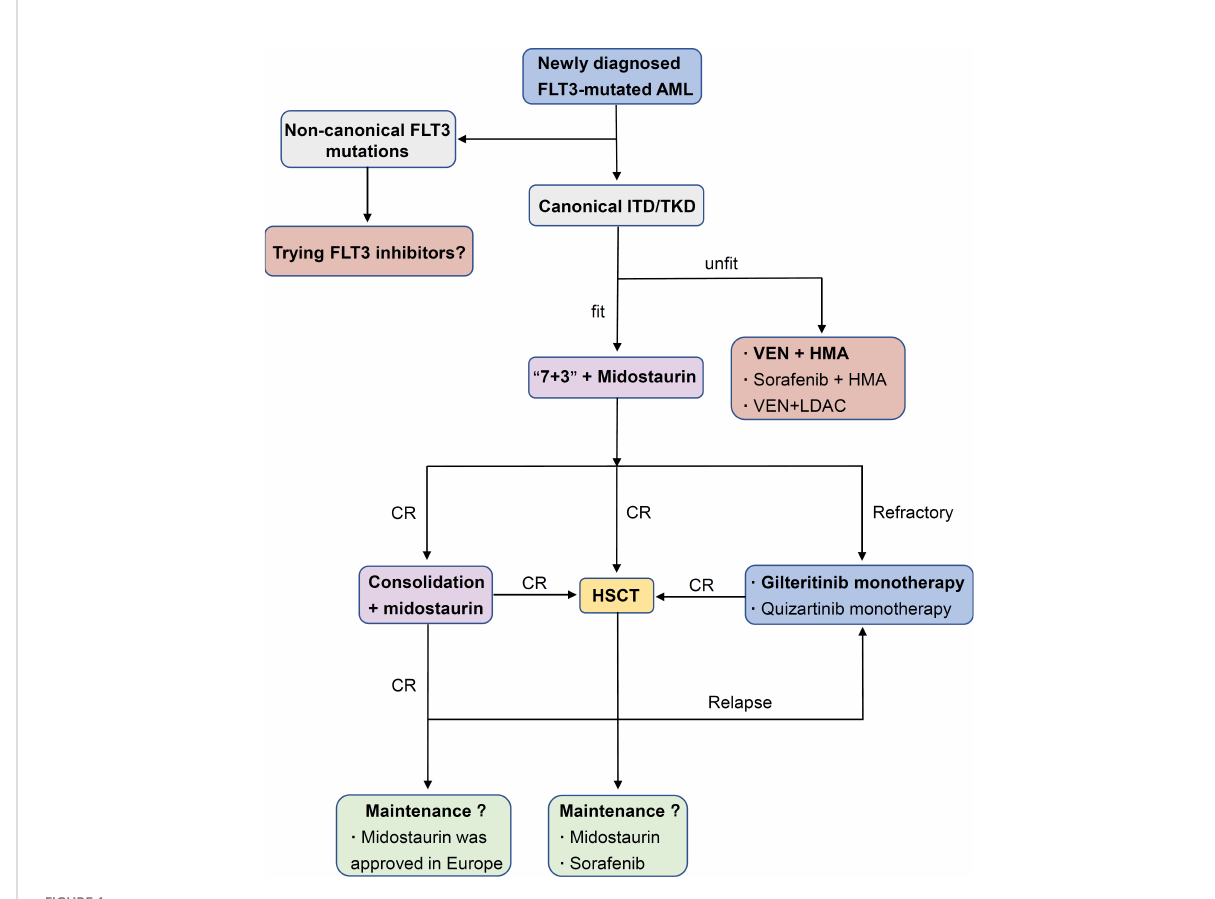
FIGURE 1 Applications of FLT3 inhibitors in